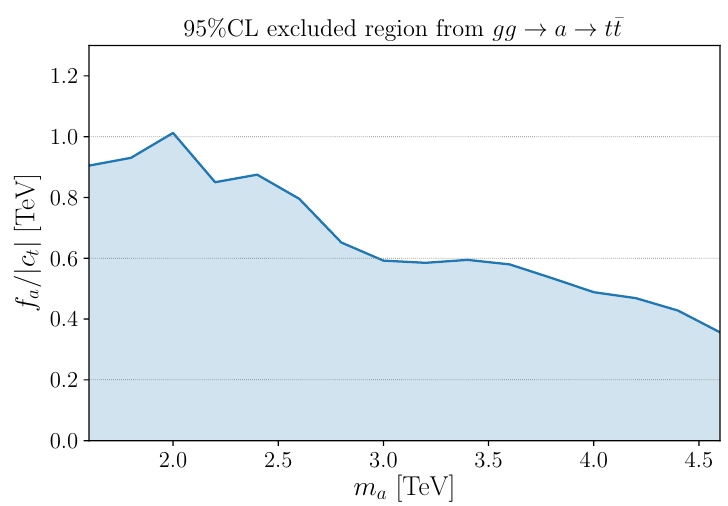
Figure 10 . Limits on f a / | c t | , as a function of the ALP mass, extracted from the all-hadronic t ¯ t resonance search by ATLAS of ref.